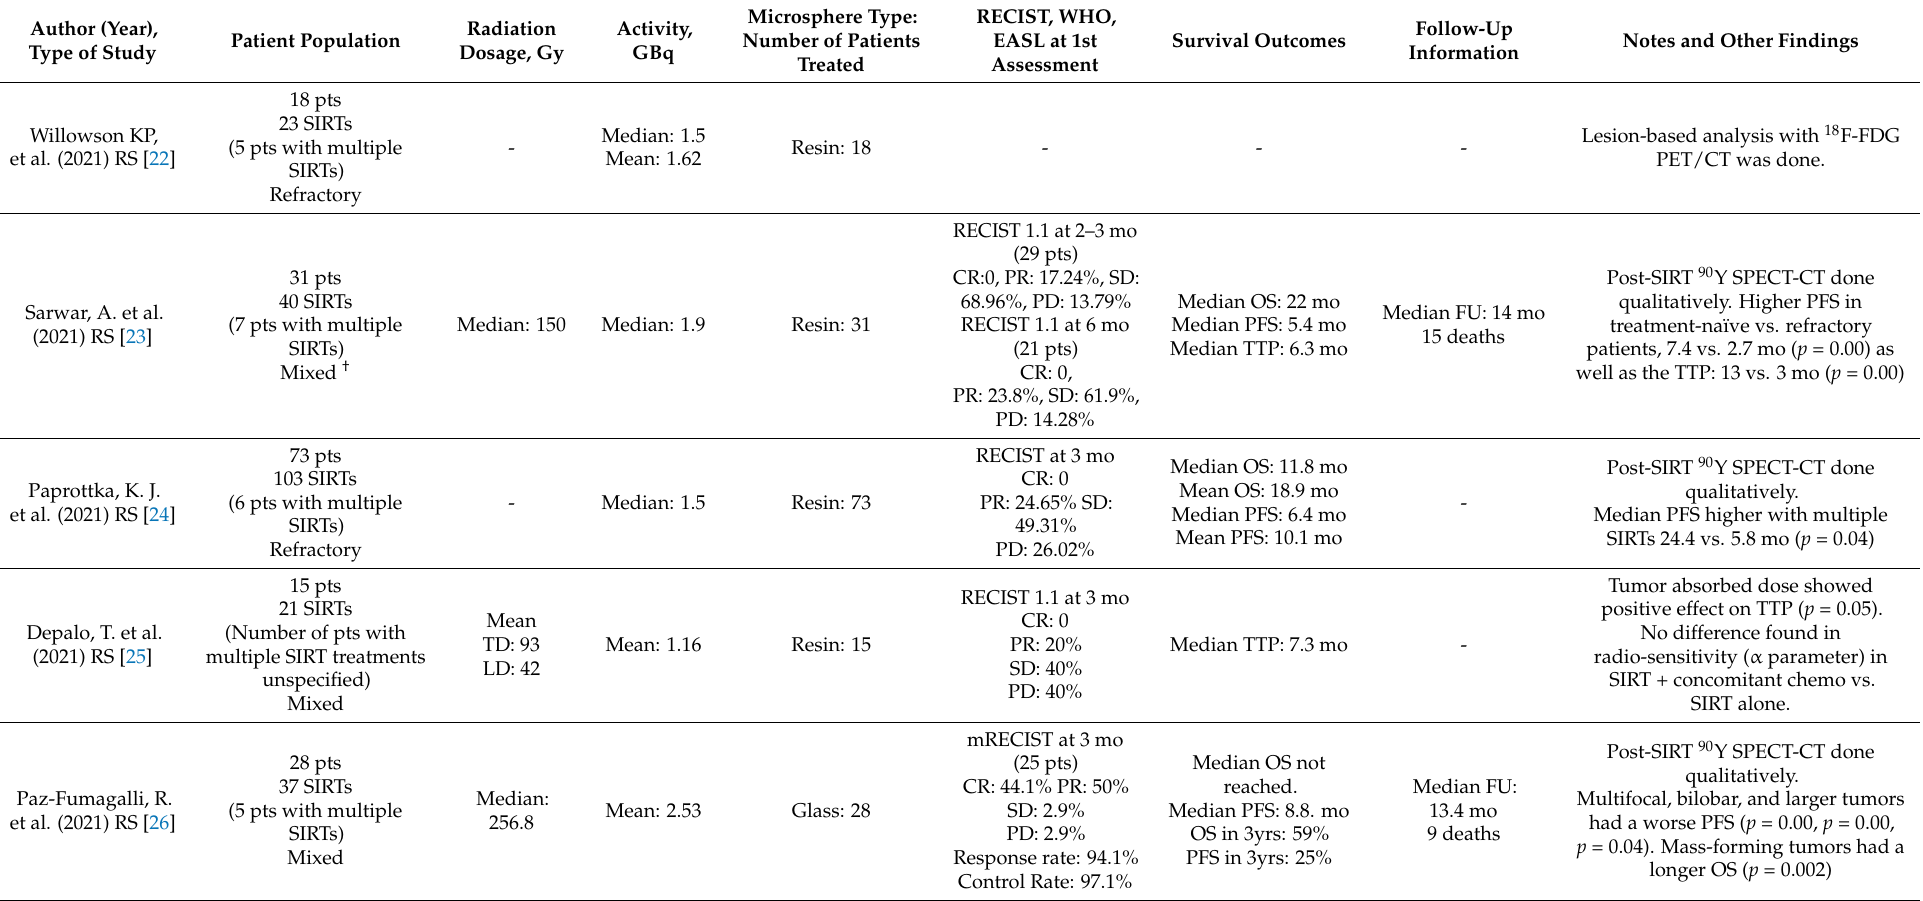
Table 1. Journal articles included in the